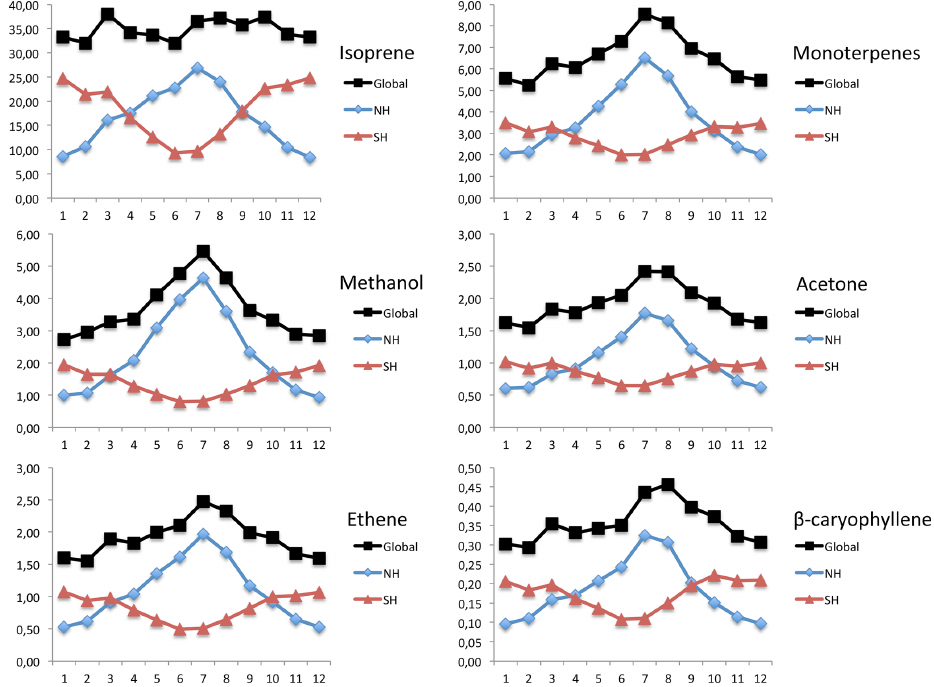
Figure 2. Global and Northern and Southern Hemisphere monthly emissions (TgCmonth − 1 ) for isoprene, the sum of monoterpenes, methanol, acetone, ethene, and β -caryophyllene averaged over the 12 years (2000–2012) of the reference